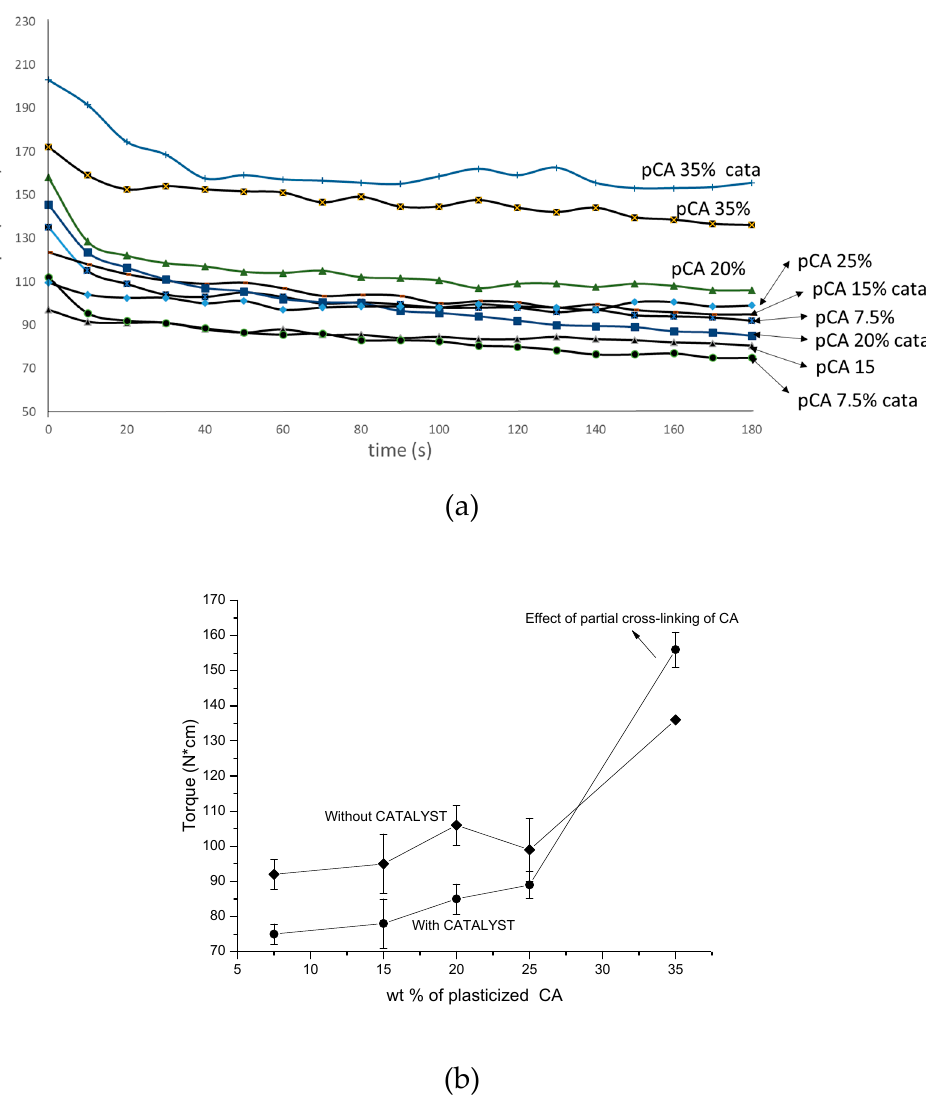
Figure 5. Torque measurements of blends prepared at 197 °C ( a ) as a function of time; ( b ) torque at 180 s as a function of pCA content. N*cm = N·cm.